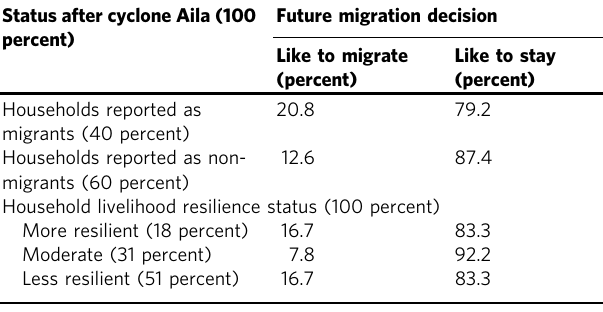
Table 3 Status of respondents after cyclone Aila, their future migration decision, and resilience status.